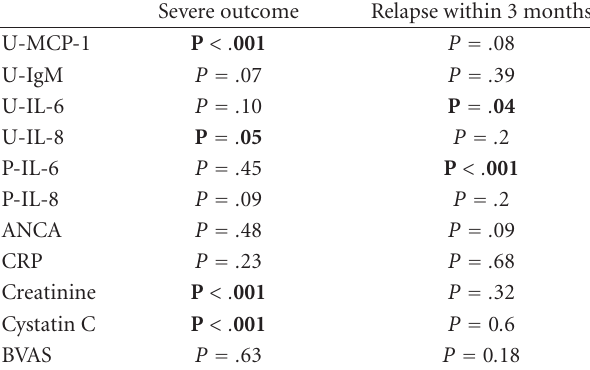
autoantibodies, CRP = C-reactive protein, BVAS = Birmingham vasculitis activity score. For statistics, the Man Whitney U-test and Kruskall-Wallis’ test were